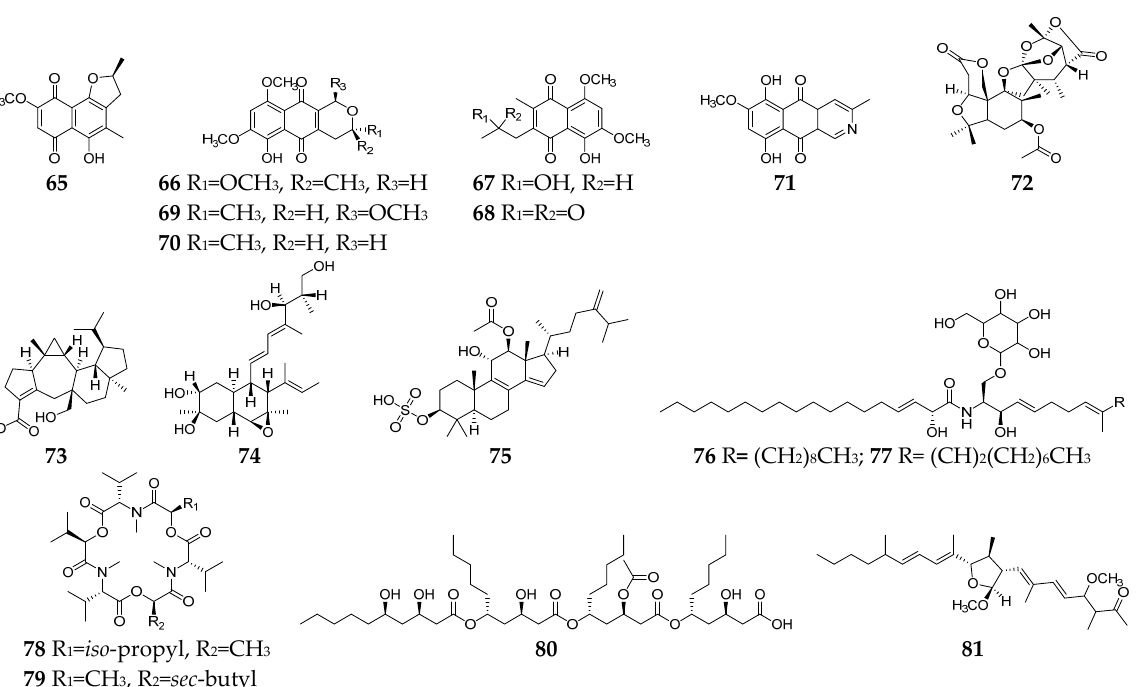
Figure 3. Fusarium -derived anti-Gram-positive and anti-Gram-negative bacterial SMs ( 65–81 ).